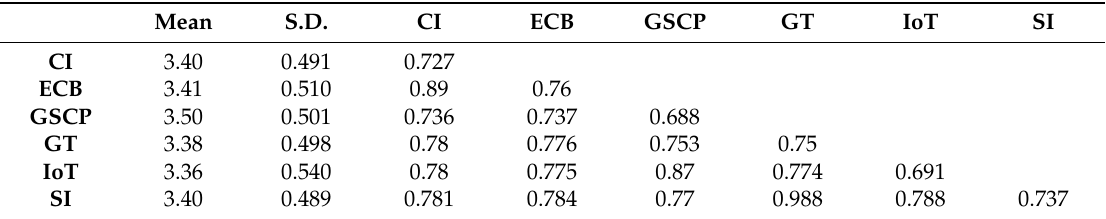
Table 2. Mean, standard deviation, and Fornell and Larcker criterion method for discriminant validity.